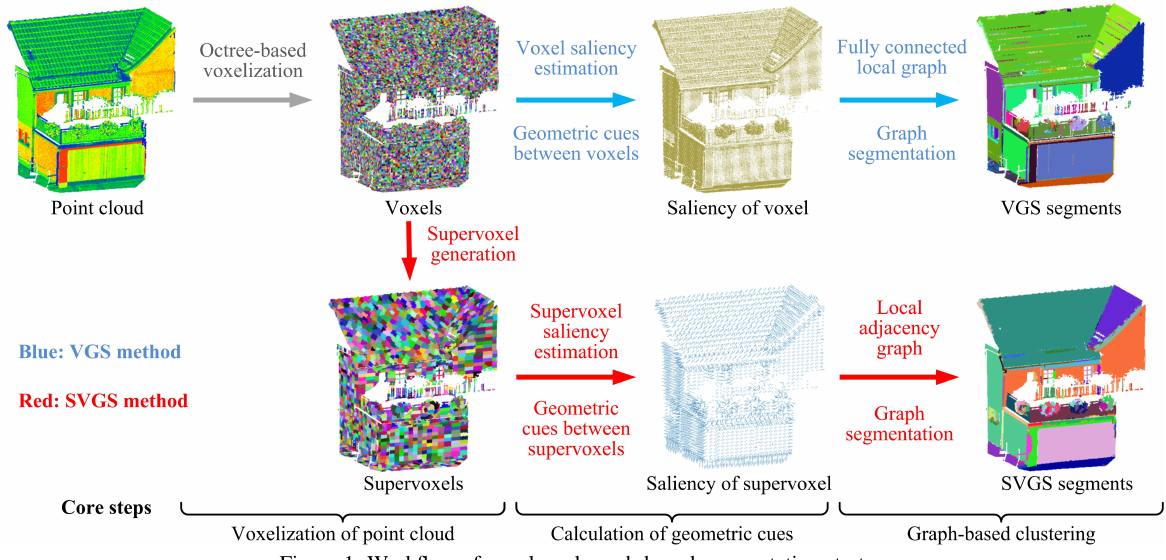
Figure 1. Workflow of voxel- and graph-based segmentation